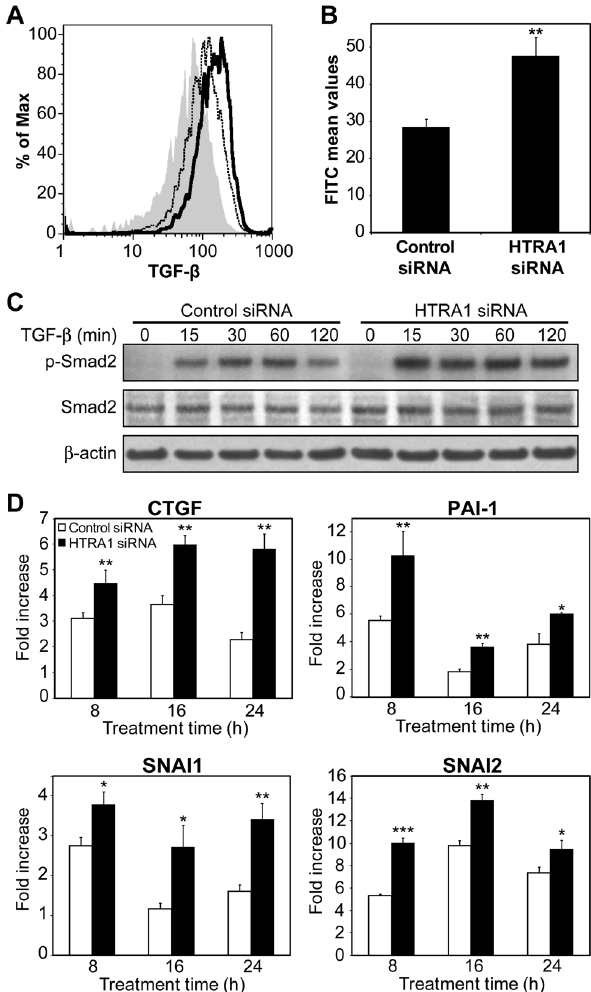
Figure 3. Regulation of TGF- b signaling by HTRA1. ( A )( B ) Binding of TGF- b to the cell surface as measured by flow cytometry. Cells were transfected with either nonspecific control siRNA or HTRA1 siRNA and then incubated with either biotinylated TGF- b or a biotinylated negative control protein to measure the background. Solid gray=back- ground, dashed line=control siRNA, black line=HTRA1 siRNA. ( B ) Bar chart indicates the mean FITC values after subtraction of the background level. ** P , 0.01, Student’s t -test, n=4. ( C ) Immunoblot of total and phosphorylated Smad2 (465/467) in A549 cells transfected with either control or HTRA1 siRNA, and then treated with 1 ng/ml TGF- b for the indicated times. b -actin was used as a loading control. ( D ) The effect of HTRA1 knockdown on the expression of TGF- b -regulated genes. A549 cells were transfected with either nonspecific control siRNA or HTRA1 siRNA and then treated with 1 ng/ml TGF- b for the indicated times. * P , 0.05, ** P , 0.01, *** P , 0.001, Student’s t -test, n=3.